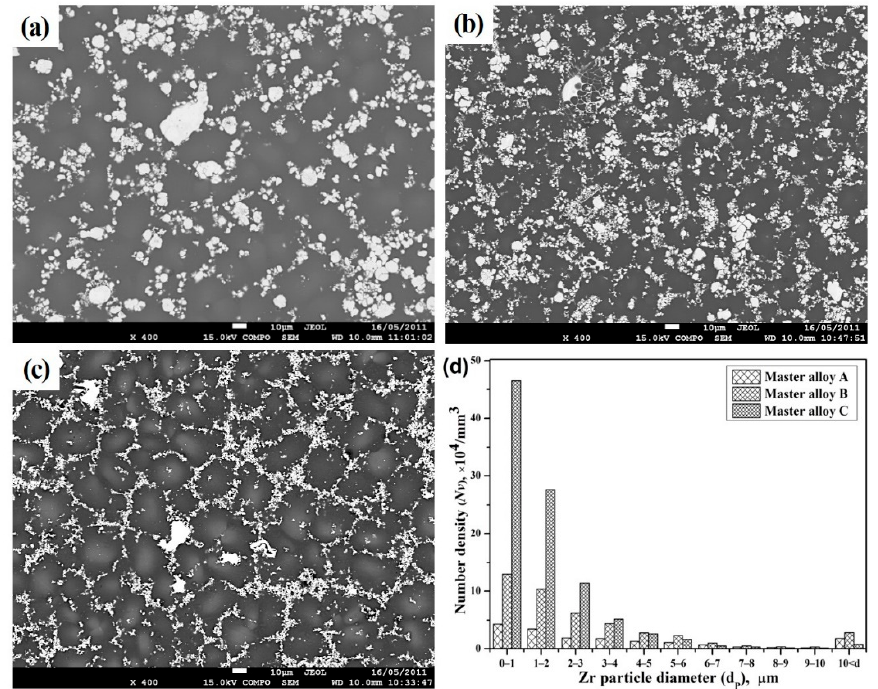
Figure 1. SEM backscattered electron (BSE) images of different Mg-Zr master alloys [25]: ( a ) Mg-30 wt.% Zr; ( b ) Zirmax ® Mg-33% Zr, ( c ) AM-CAST ® Mg-25 wt.% Zr; and ( d ) Zr particle size distributions [26]. Reprinted with permission from ref. [26]. Copyright 2013 Wiley.